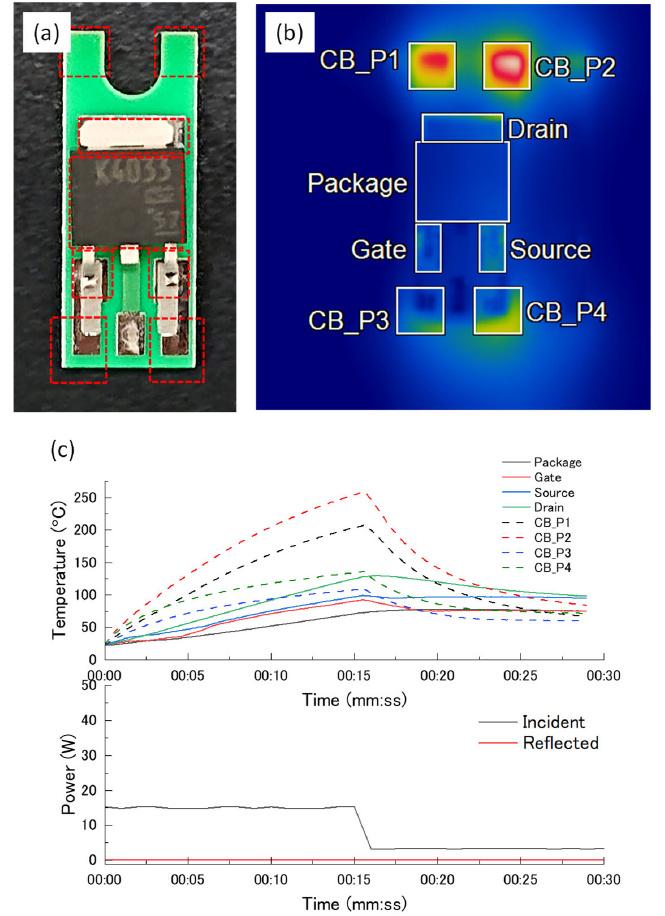
Figure 4. Photographic image of sample ( a ) and thermal image of sample heated in a TM 010 cavity ( b ), and temperature (upper) and power (bottom) profiles over time for microwave heating in a TM 010 cavity( c ). The positions of the calculated temperature are shown as red dashed rectangles in ( a ). Temperatures were highest in the range of each white rectangle in ( b